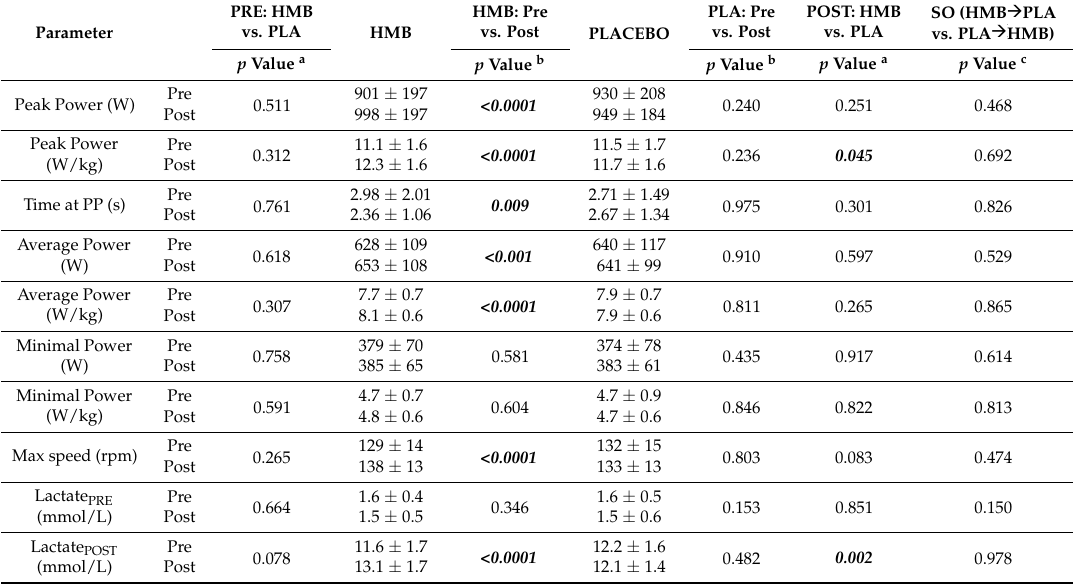
Table 5. Levels of the monitored anaerobic capacity parameters before and after the 12-week supplementation with HMB and placebo preparation.